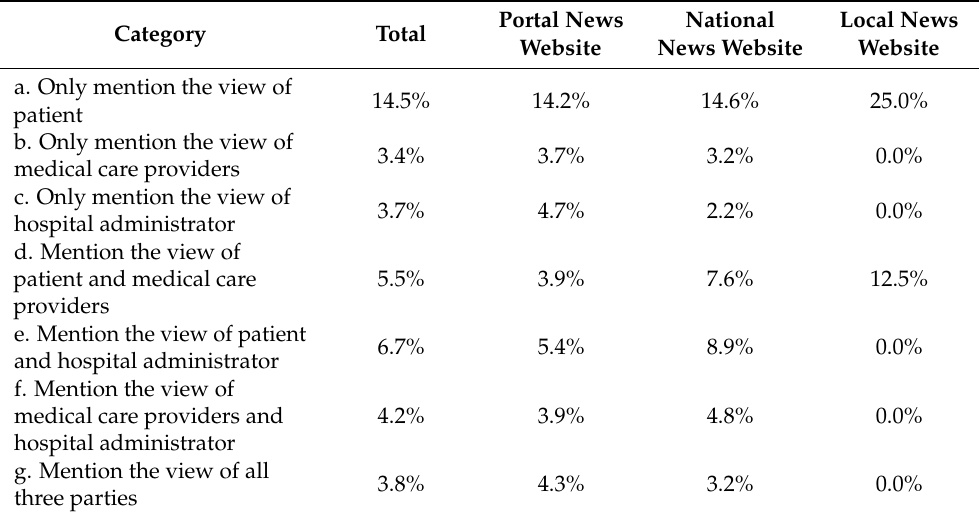
Table 2. Percentage of Chinese media reports about violence against medical care providers mention- ing the perspectives of medical care providers, patients, and hospital